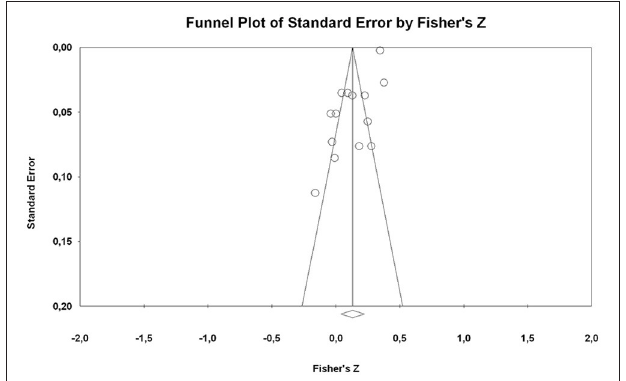
FIGURE 3 | Funnel plots of effect sizes of the correlation between ITI and student’s quantitative domain achievement.